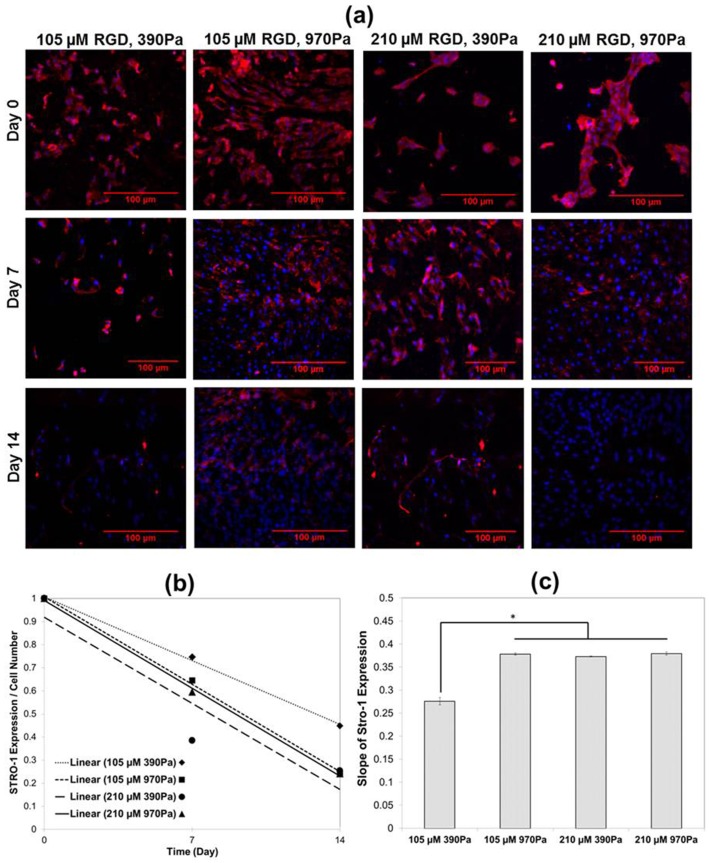
Dependence of cell differentiation on stiffness and adhesion peptide density.(a) Representative STRO-1 staining of hMSCs after culture in osteogenic induction media for 0, 7 and 14 days on various sIPNs, as assessed by STRO-1 positive cells (red) and nuclei (DAPI; blue). Scale bar  = 100 µm. (b) Relative time dependent expression of STRO-1 on various sIPNs. (c) Rate of decrease (i.e., slope of correlation in panel b) of STRO-1 protein expression. *p<0.05, ANOVA and Tukey post-hoc tests with n = 3 sIPNs.